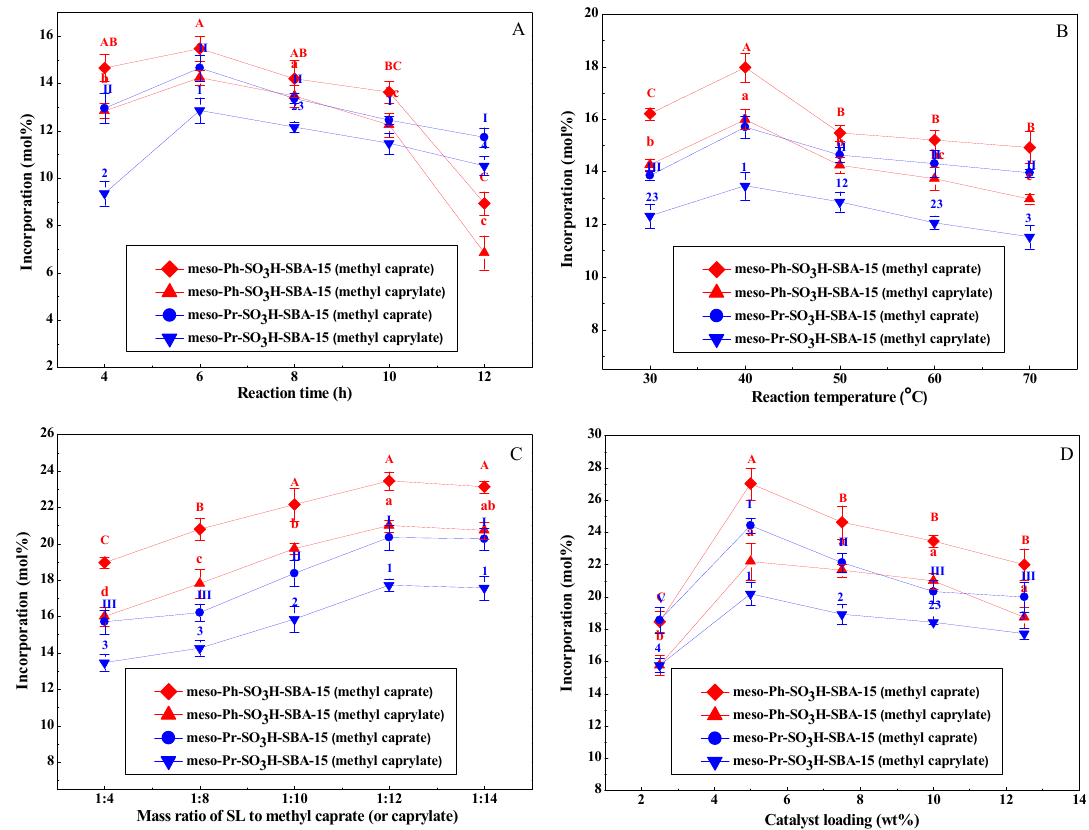
Figure 6. ( A ) Effect of reaction time on SL interesterification over two modified SBA ‐ 15 samples. SL: 0.1 g, methyl caprate (or caprylate): 1.45 g (or 1.20 g), catalyst: 10 wt% of total mass, 50 °C. ( B ) Effect of reaction temperature on SL interesterification over two modified SBA-15 samples. SL: 0.1 g,